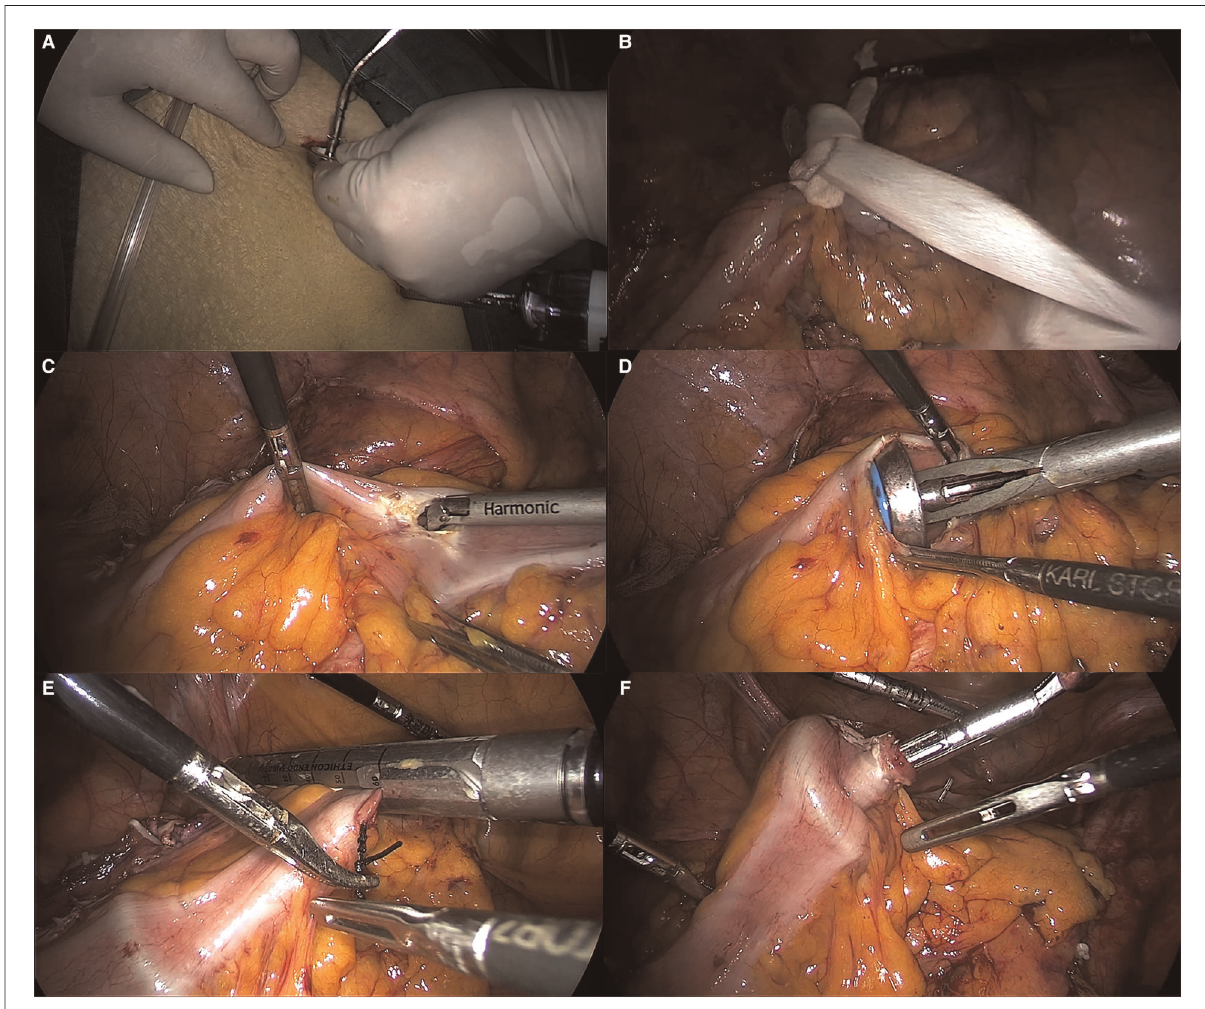
FIGURE 1 RPD technique. ( A ) The main operation hole is expanded, and the RPD is inserted with wire. ( B ) The proximal bowel is secured with string. ( C ) A longitudinal incision was made into the proximal bowel. ( D ) Intestinal placement of RPD ( E ) The silk suture was pulled against the anvil, and the precut line was used to disconnect the intestinal canal. ( F ) The anvil center rod was pulled